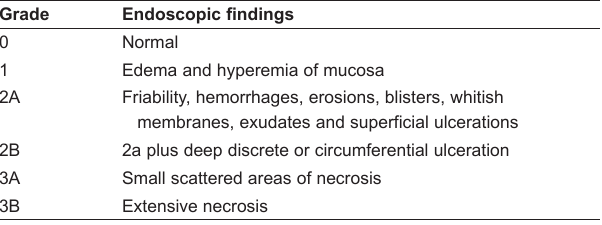
TAbLe 1 endoscopic grading of caustic mucosal injuries